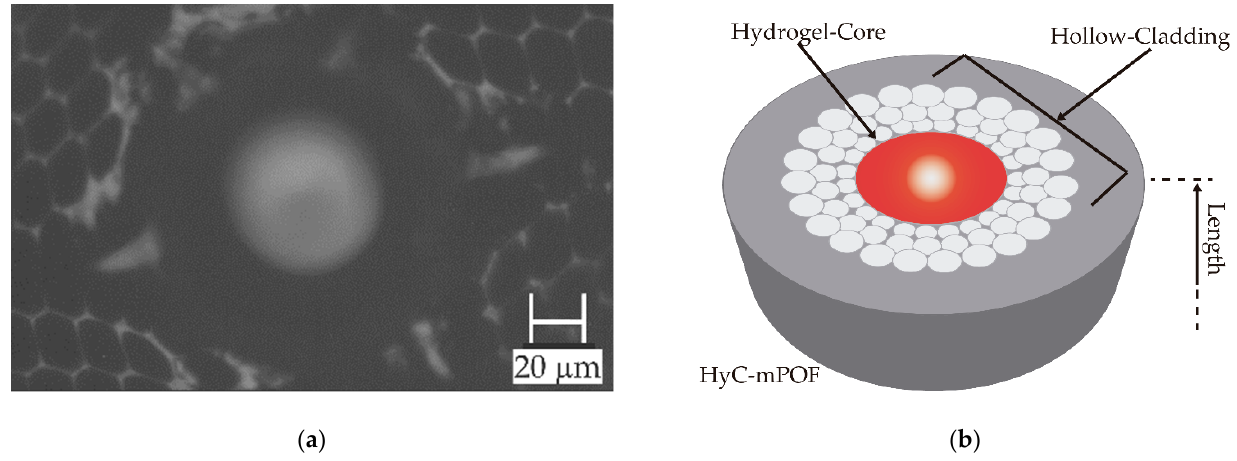
Figure 2. ( a ) Cross-section microscope photograph of a HyC-mPOF end-face. The presence of the hydrogel is observed as the blurred circle on the hollow of the microstructure. A HyC-mPOF end-face image obtained from the microscope; ( b ) a 3D illustration of the upper end-face of a HyC-mPOF.